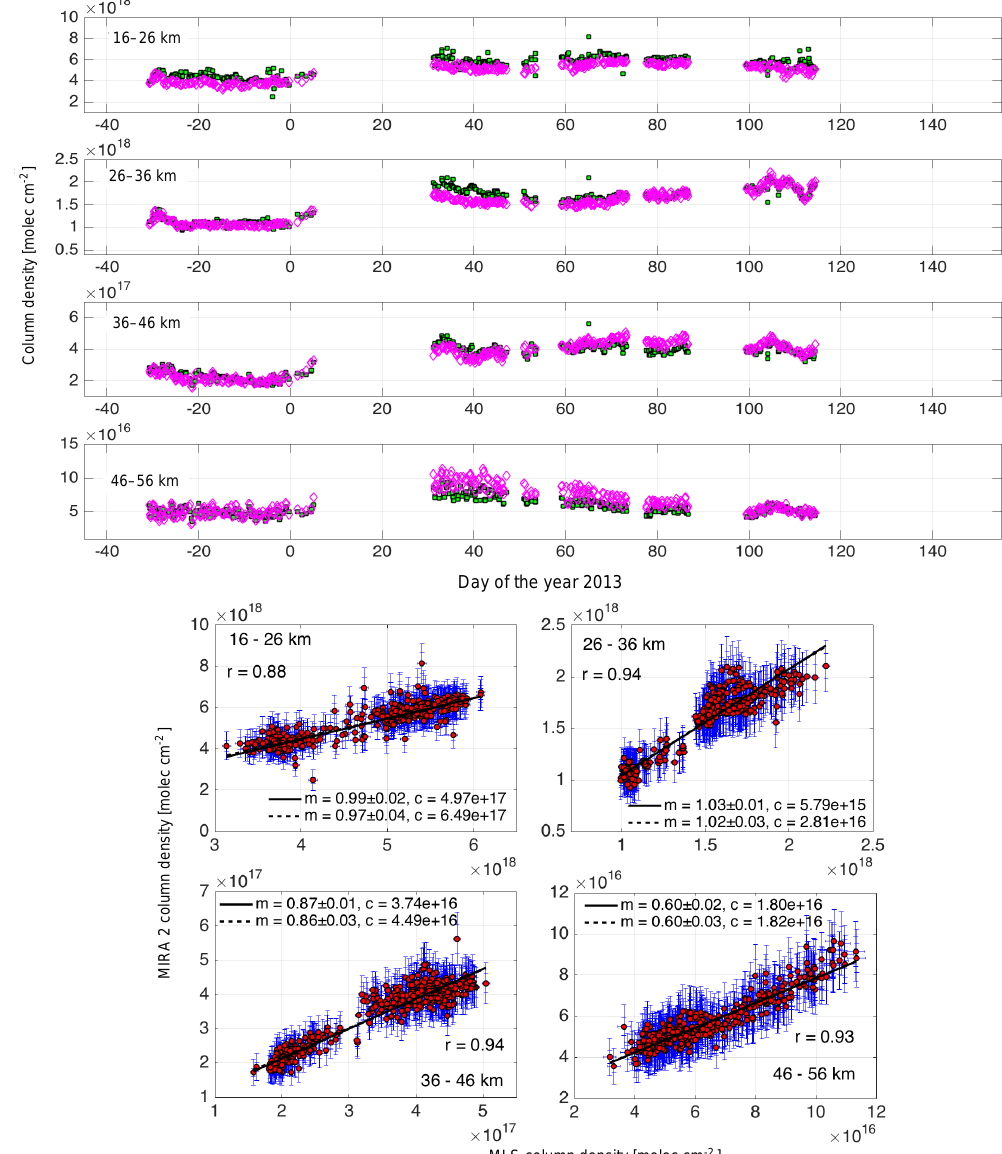
Figure 10. Same as Fig. 9 but for MIRA 2 (green filled squares) and MLS (hollow magenta